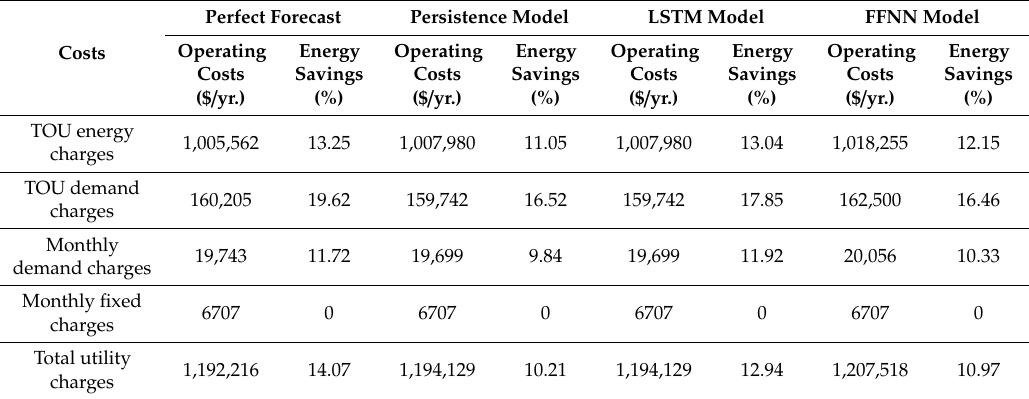
Table 8. Optimal operation